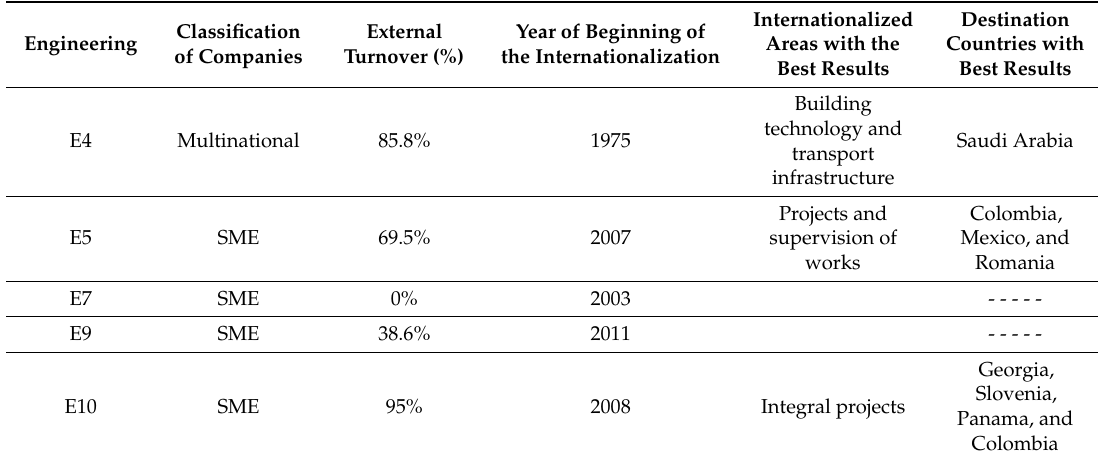
Table 9. Characteristics of the companies that give the highest score to risk management.